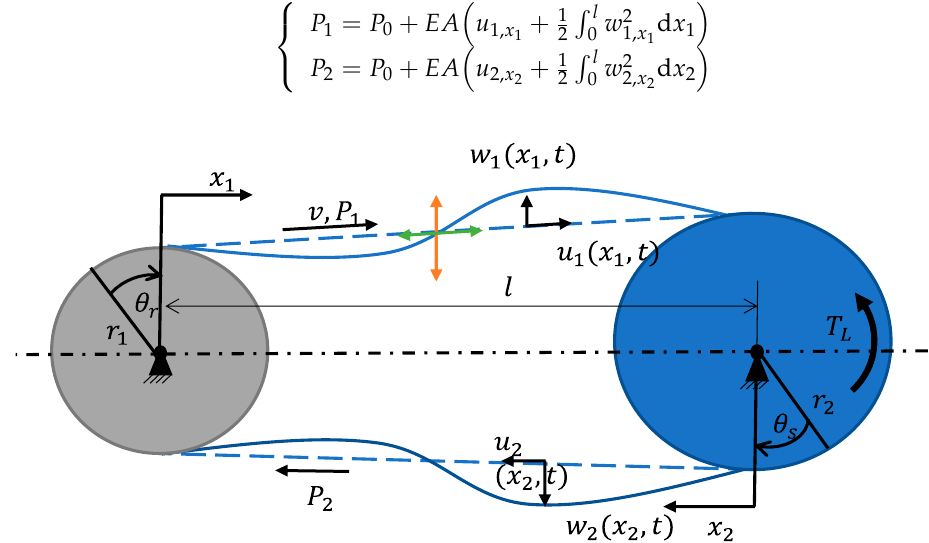
Figure 4. Two-pulley belt drive mechanical model.